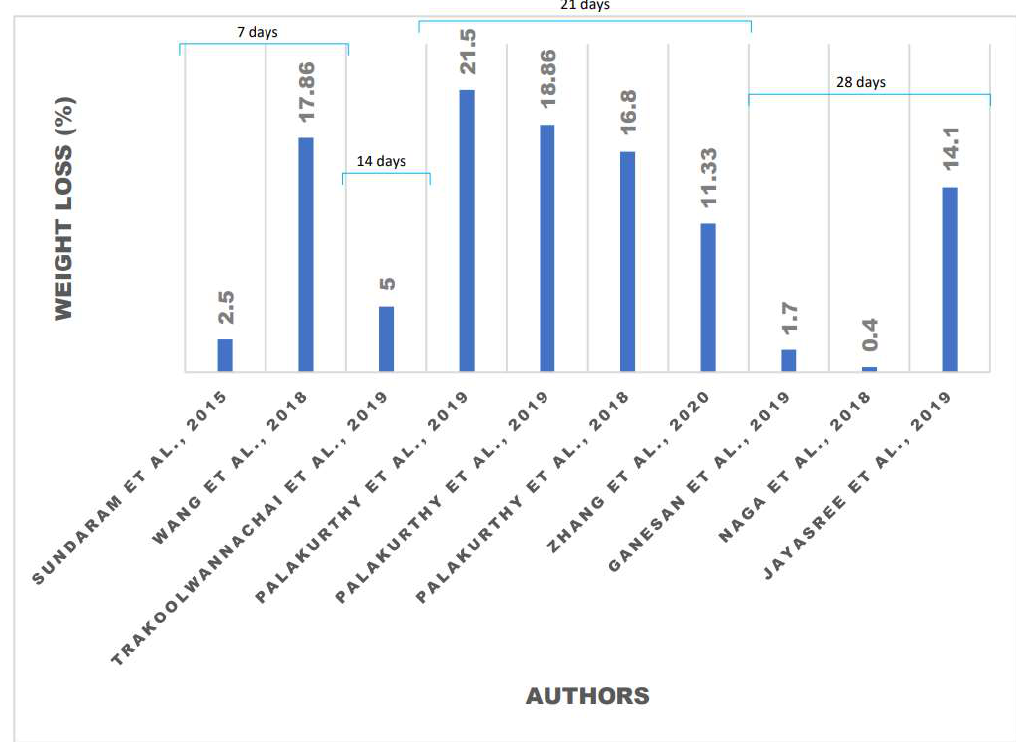
Figure 6. Weight loss of the eggshell-based hydroxyapatite after soaking for various times. In vitro cell culture testing provides information on the biocompatibility of the ma- terial [11]. There are two types of stem cells used for cultured in cytotoxicity test by optical density results, i.e. stem cells from humans [2,49,50], shown in Table 3, and stem cells from animals [11], shown in Table 4. Using cell culture methods can also stimulate cell prolif- eration [2]. The stem cells are usually used as permanent cells because they are similar to human bone osteoblasts [49]. If the optical density increases, the surface area also in- creases for cell adhesions. Cell adhesions provide advantages for growth and cell viability [50]. Materials that use eggshell-based hydroxyapatite have good optical density results because the absorbance for all porous scaffolds higher than control due to the high surface area determined by the porous morphology and the bioactive properties of calcium phos- phate [2]. As shown in Figure 4, it was found that the material culture in stem cells does not cause cytotoxicity. Materials for bone tissue engineering applications must be used without provoking any immune response in the human body [45]. Cell toxicity is one of the challenges related to the application of bone tissue engineering and the manufacturing of new biomaterials [14]. Cytotoxicity testing is used to determine metabolic function and cell health in the bone tissue environment [26]. One of the factors measured with cytotoxicity testing is cell